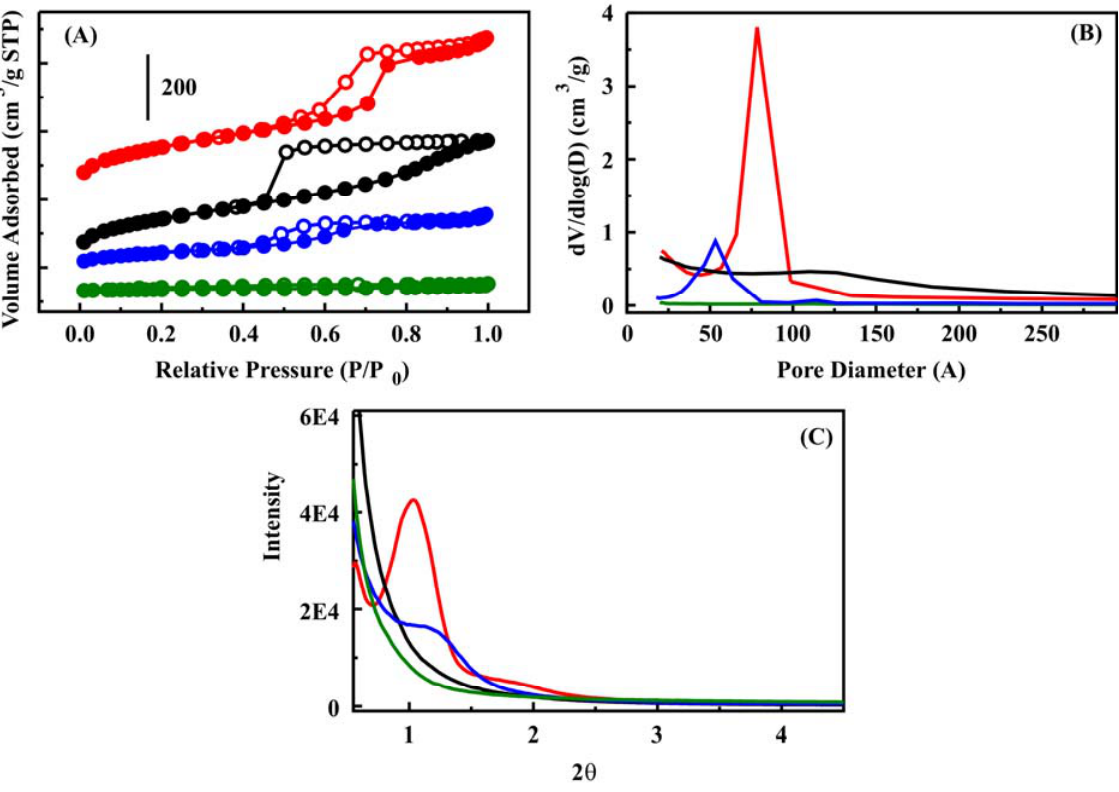
Figure 1. ( A ) Nitrogen sorption isotherms for sorbent with hexagonally packed pores (HX) (red, shifted +200), sorbent with disordered pore arrangement (CF) (black, shifted +110), HX1M3B (blue), and CF1M3B (green) sorbents; ( B ) Pore size distributions for HX, CF, HX1M3B, and CF1M3B. The inset shows a zoom view of the HX1M3B and CF1M3B pore size distributions; ( C ) X-ray diffraction patterns for HX (red), CF (black), CF2 (blue), and CF3 (green) sorbents.